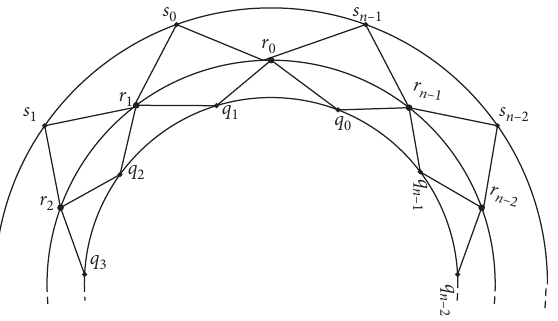
Figure 1: : Double antiprism graph A ∗